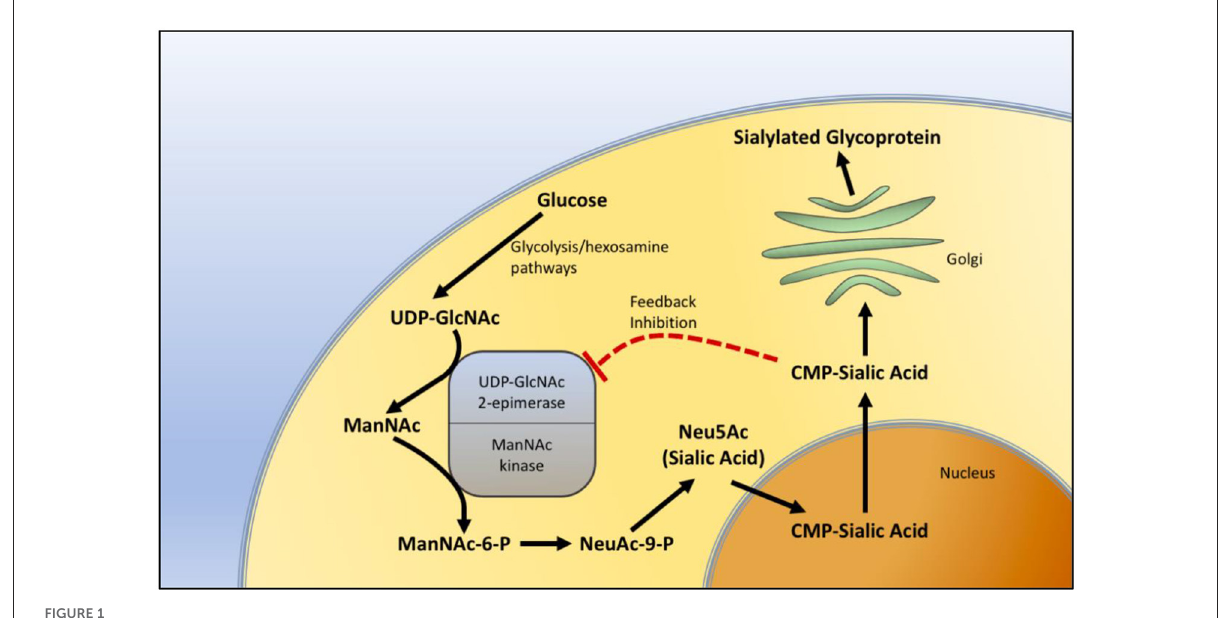
FIGURE1 Sialic acid biosynthesis pathway. The biosynthesis of sialic acid in the cell. Uridine diphosphate N-acetylglucosamine (UDP-GlcNAc), a metabolite of the glycolytic and hexosamine pathways, is epimerized to N-Acetylmannosamine (ManNAc) and then phosphorylated to N-Acetylmannosamine-6-phosphate (ManNAc-6-P) by sequential components of the GNE enzyme, representing the two rate-limiting steps in the production of sialic acid. In the nucleus, sialic acid is further metabolized into the active form of sialic acid, cytidine-5’-monophosphate N-acetylneuraminic acid (CMP-sialic acid) and then added to glycoproteins in the Golgi during the process of sialylation. CMP-sialic acid also provides feedback inhibition of UDP-GlcNAc